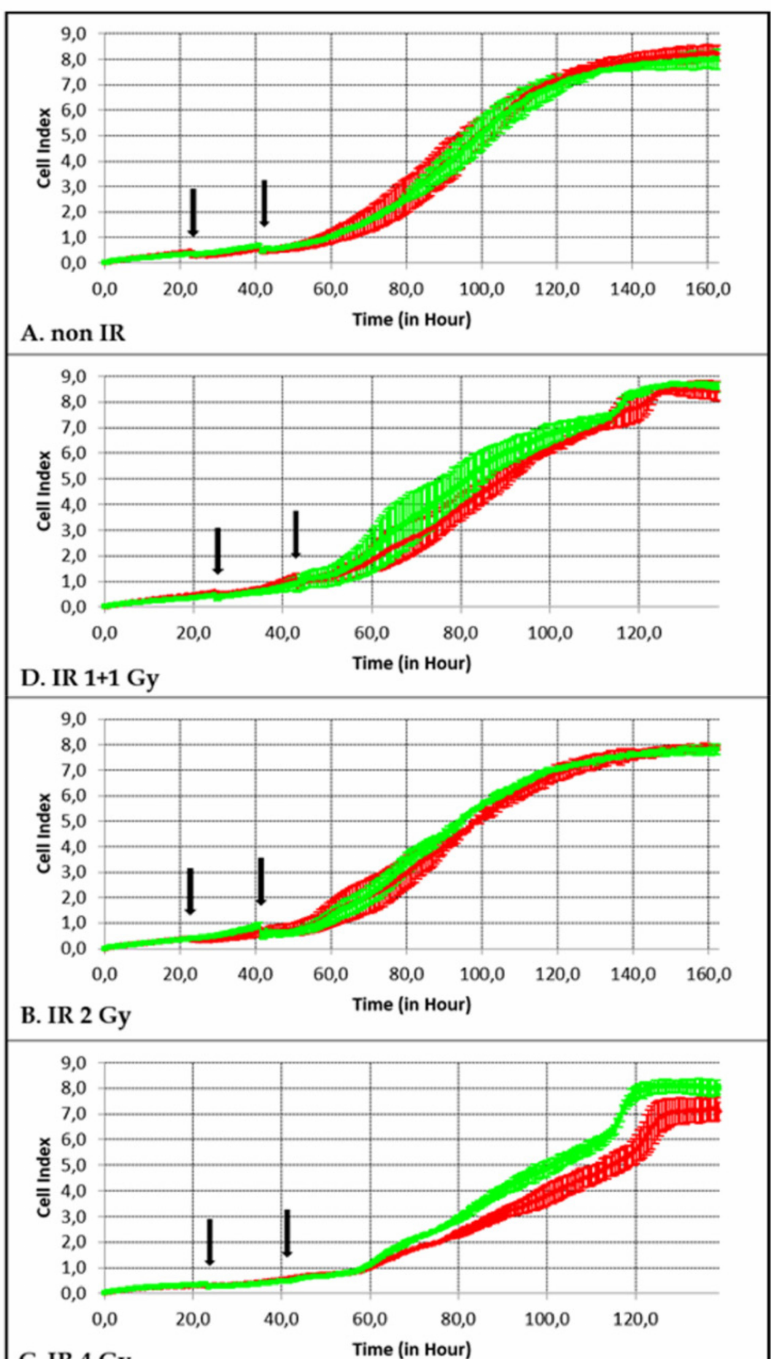
Figure 17. Real-time monitoring (xCELLigence RTCA) of SkBr3 cell adhesion after irradiation with the indicated doses of γ -rays in absence ( green ) or presence ( red ) of GNPs (18-h incubation with 0.4 µ g/mL GNPs). The graphs show the cell adhesion as the mean cell index value from 2-well plates ( ± SD) plotted against post-irradiation time. Time point 0 denotes the point at which the E-plate was first scanned after cell addition. The graph shows the results for 4000 cells seeded at the beginning of the experiment, as this seeding density was identified as optimal. The time points of GNP addition and irradiation plus GNP removal are indicated by black